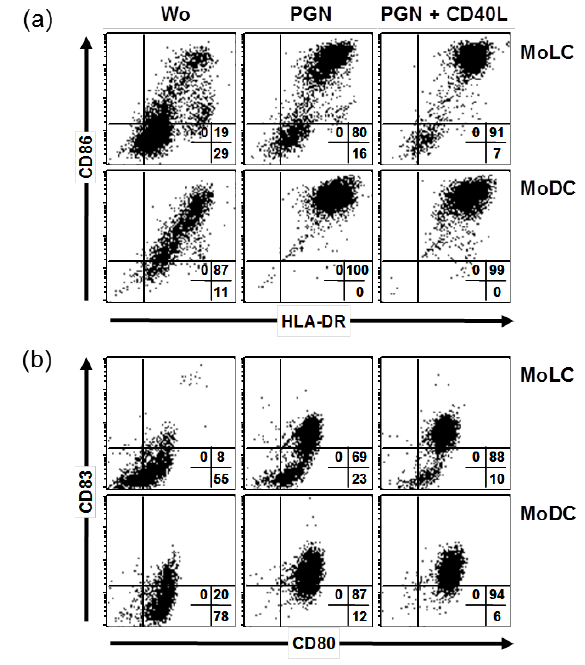
Figure 1. PGN and CD40 ligand synergize in upregulating maturation molecules on MoLCs. Derived from the same PBMC, MoDCs and MoLCs were stimulated for 48 h by TLR2 agonist 20 µg/mL PGN and 1 µg/mL trimer of CD40 ligand or remained without stimulus (Wo). ( a ) Expression of CD86 and HLA-DR and ( b ) expression of CD80 and CD83 was detected by flow cytometry on the surface of MoLCs (upper panel) and MoDCs (lower panel). Quadrants indicate staining with isotype controls, numbers percent positive cells. Dot plots shown are representative for four independent experiments with different donors.